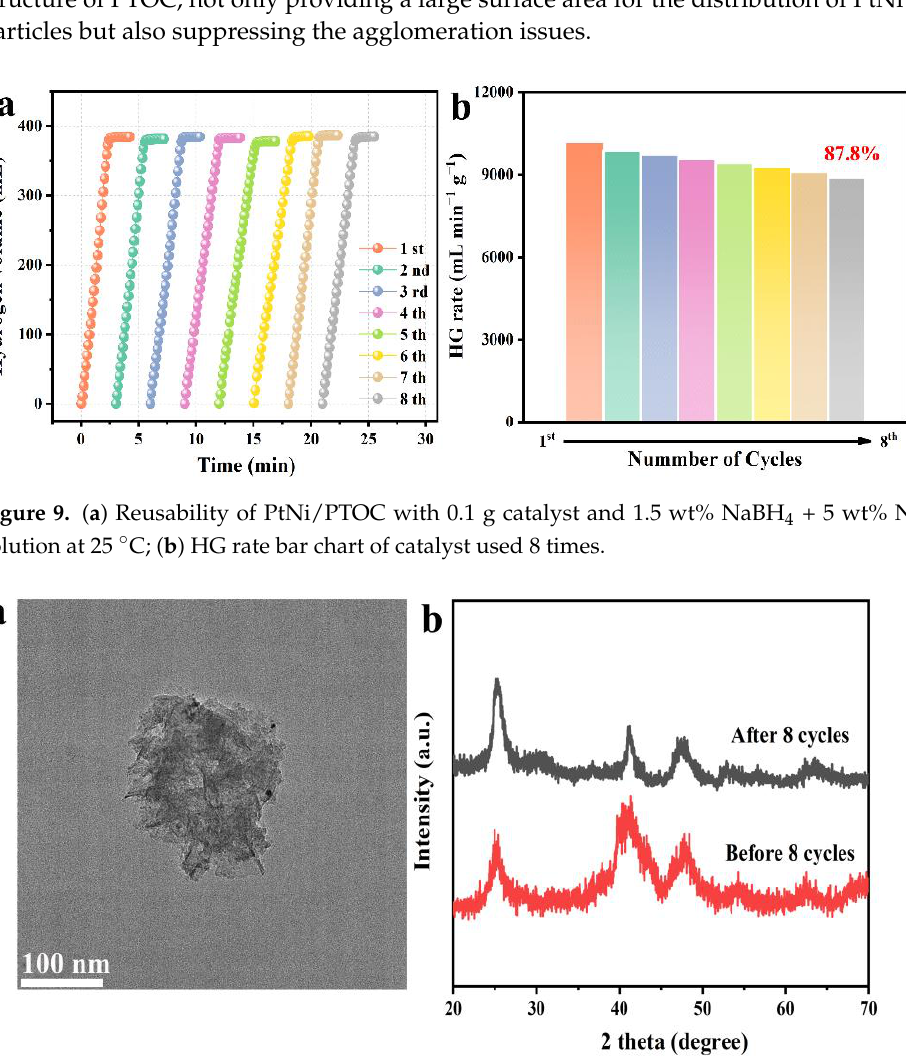
Figure 10. ( a ) TEM images of the PtNi/PTOC catalyst after 8 cycles; ( b ) XRD patterns of the PtNi/PTOC catalyst before cycling and after 8 cycles.